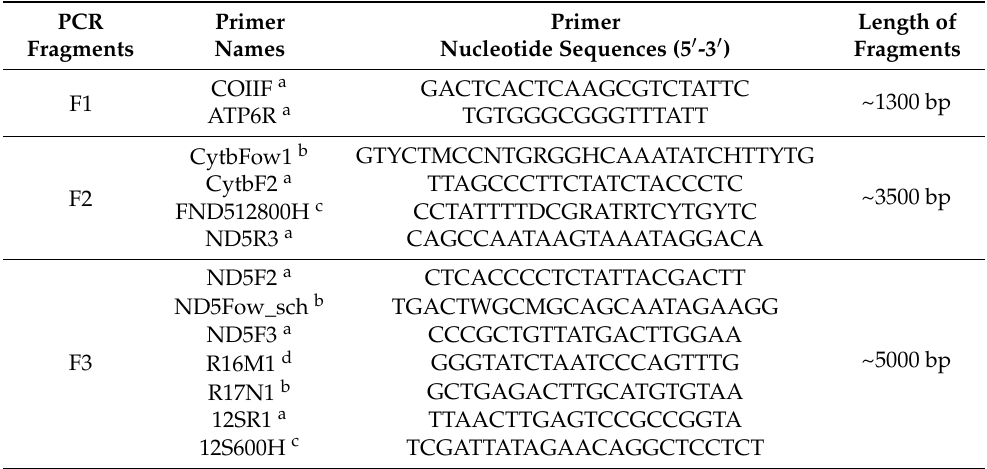
Table 1. PCR primers used in this